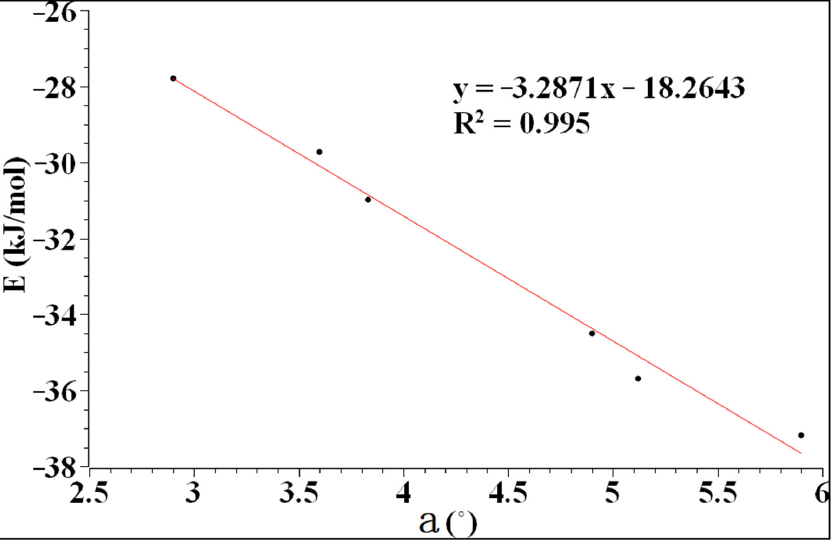
Figure 3. The relationship between the interaction energy and